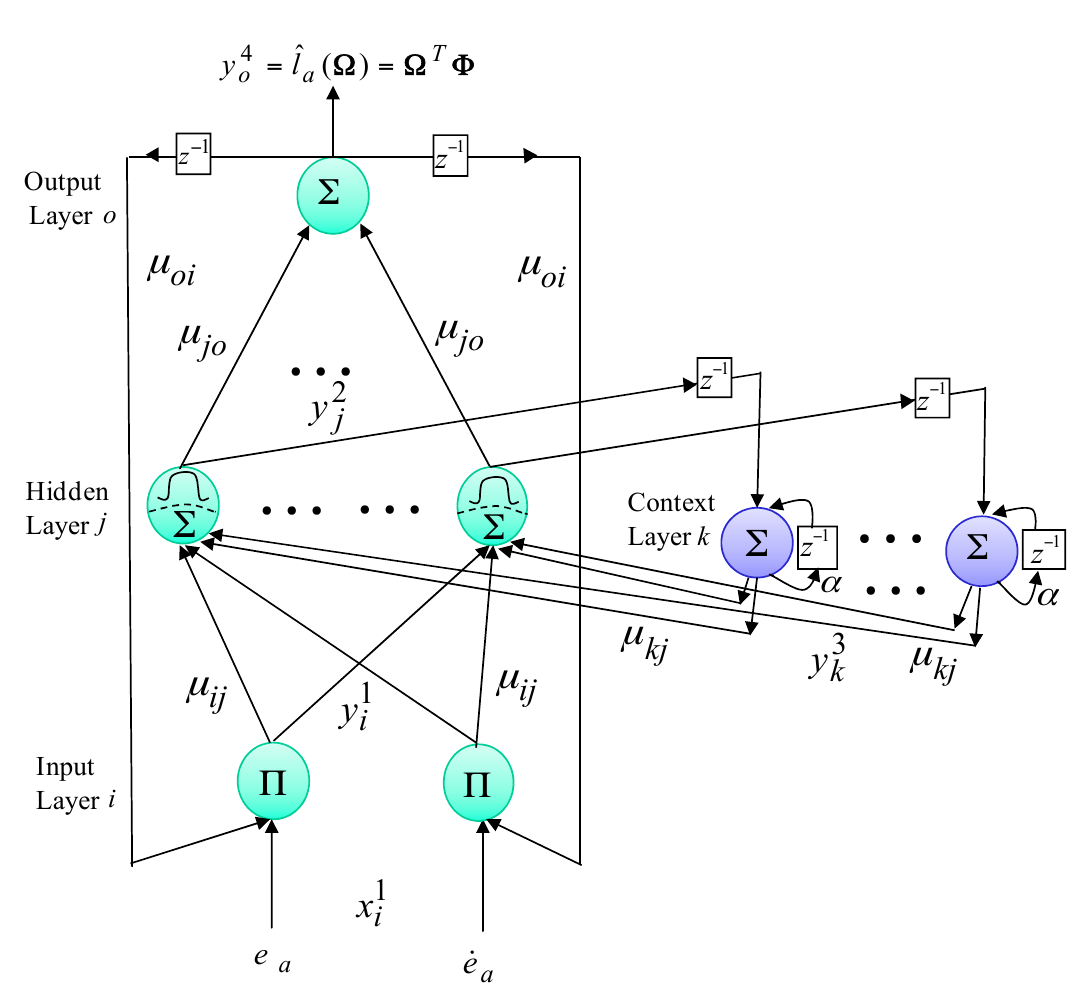
Figure 4. Composition of the four-layer AENN.